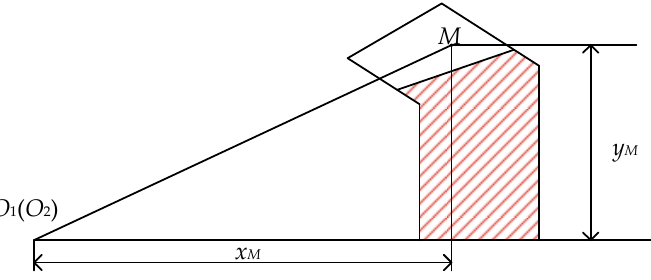
Figure A4. Tooth face point in the rotation projection plane.